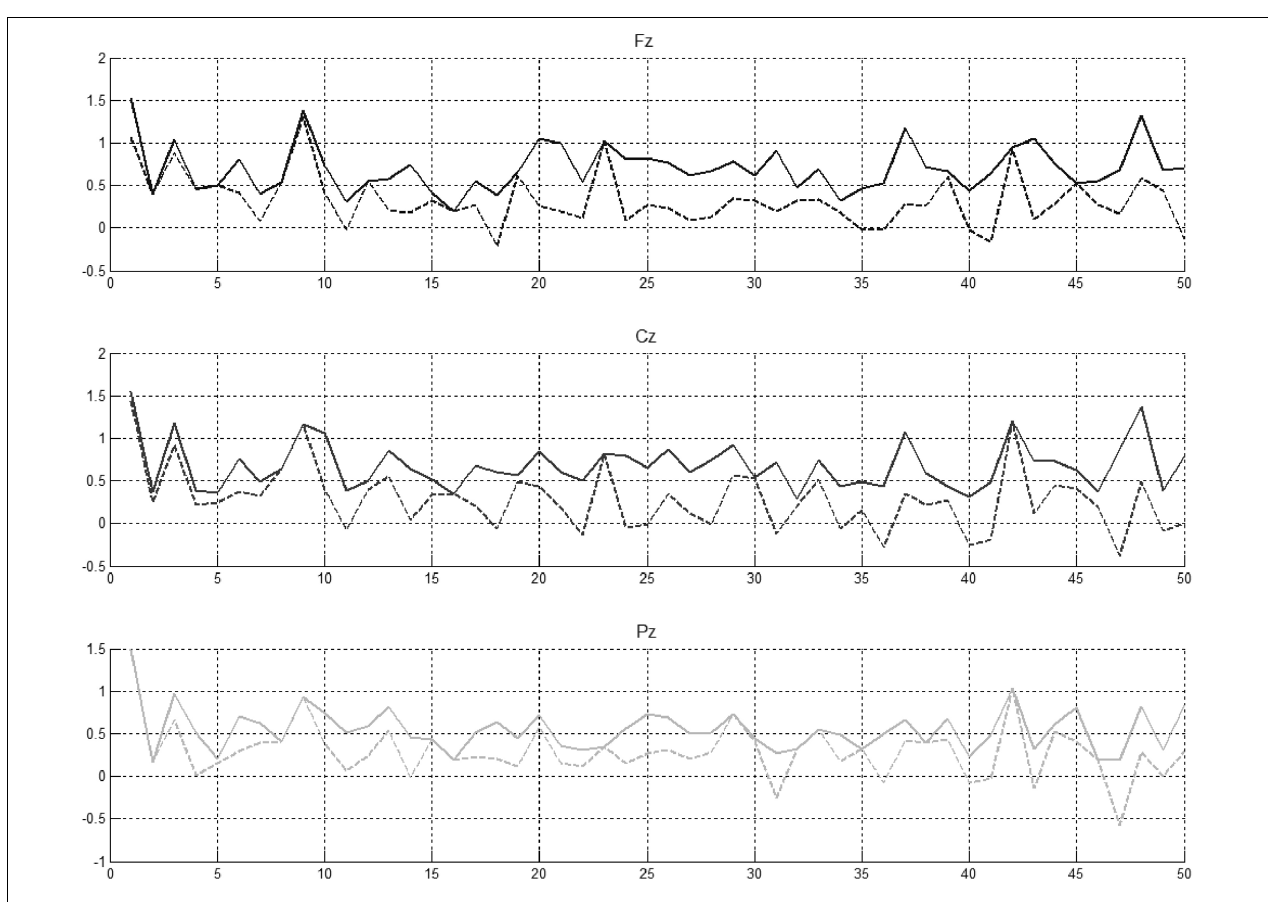
FIGURE 5 | Preceding novel stimuli (NG) vs. amplitude of the P300 peak in Fz, Cz, and Pz. P300 peak amplitudes between 250 and 450 ms (solid lines) and between 350 and 450 ms (dotted lines) computed for control participants.